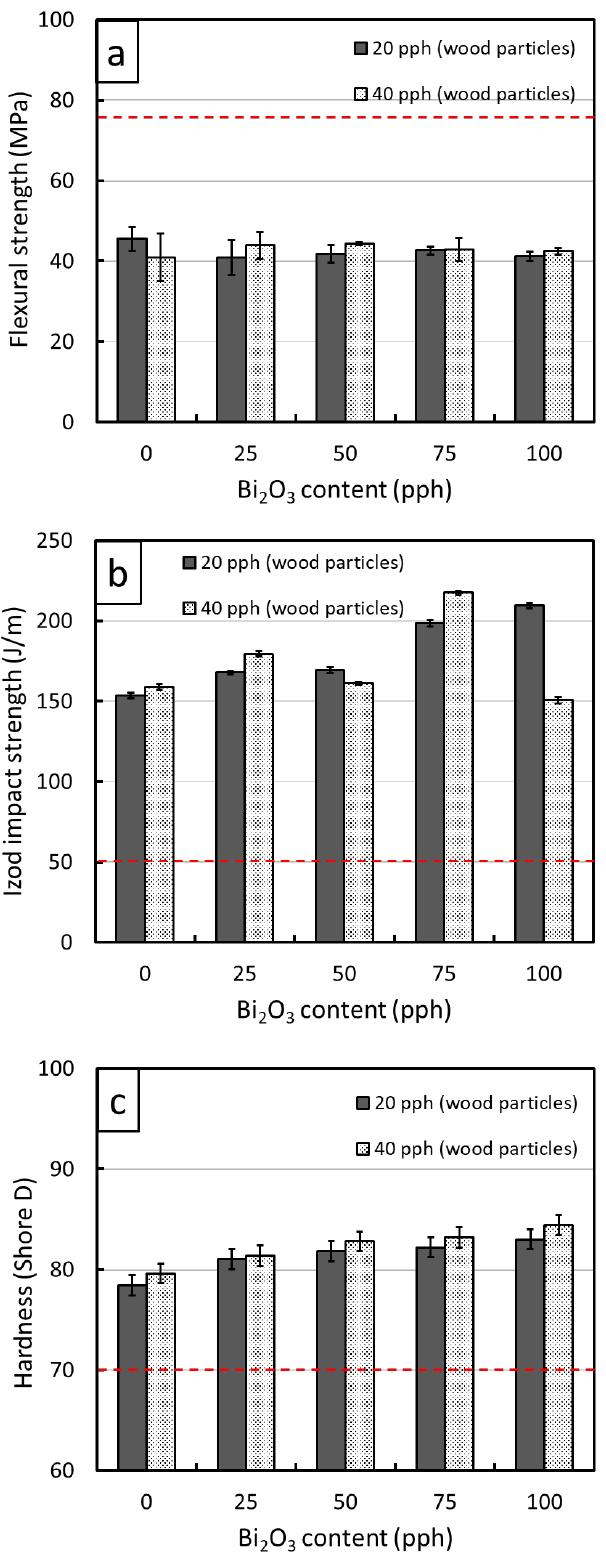
Figure 3. ( a ) Flexural strength, ( b ) Izod impact strength, and ( c ) hardness (Shore D) of WPVC composites containing 0–100 pph of Bi 2 O 3 and 20–40 pph of wood particles, where error bars = ± standard deviation. The red-dashed lines represent flexural strength, Izod impact strength, and hardness (Shore D) of a neat PVC obtained from [37 – 39].